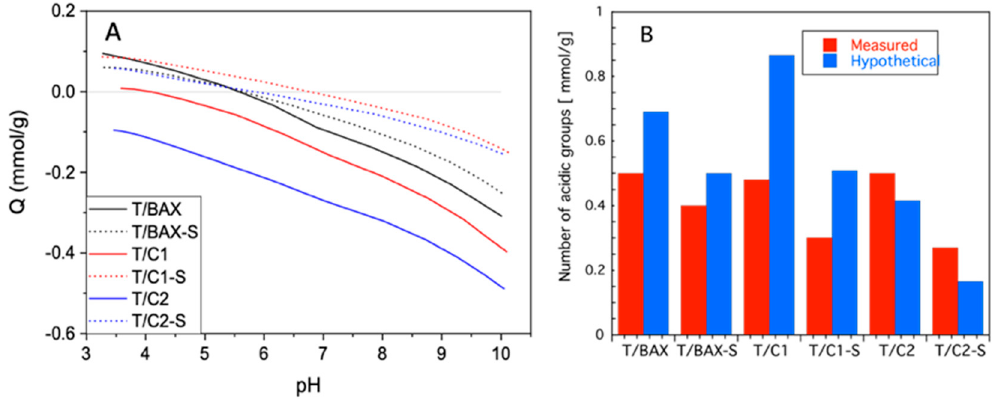
Figure 6. ( A ) Proton binding curves; ( B ) Comparison of measured and hypothetical numbers of surface groups.